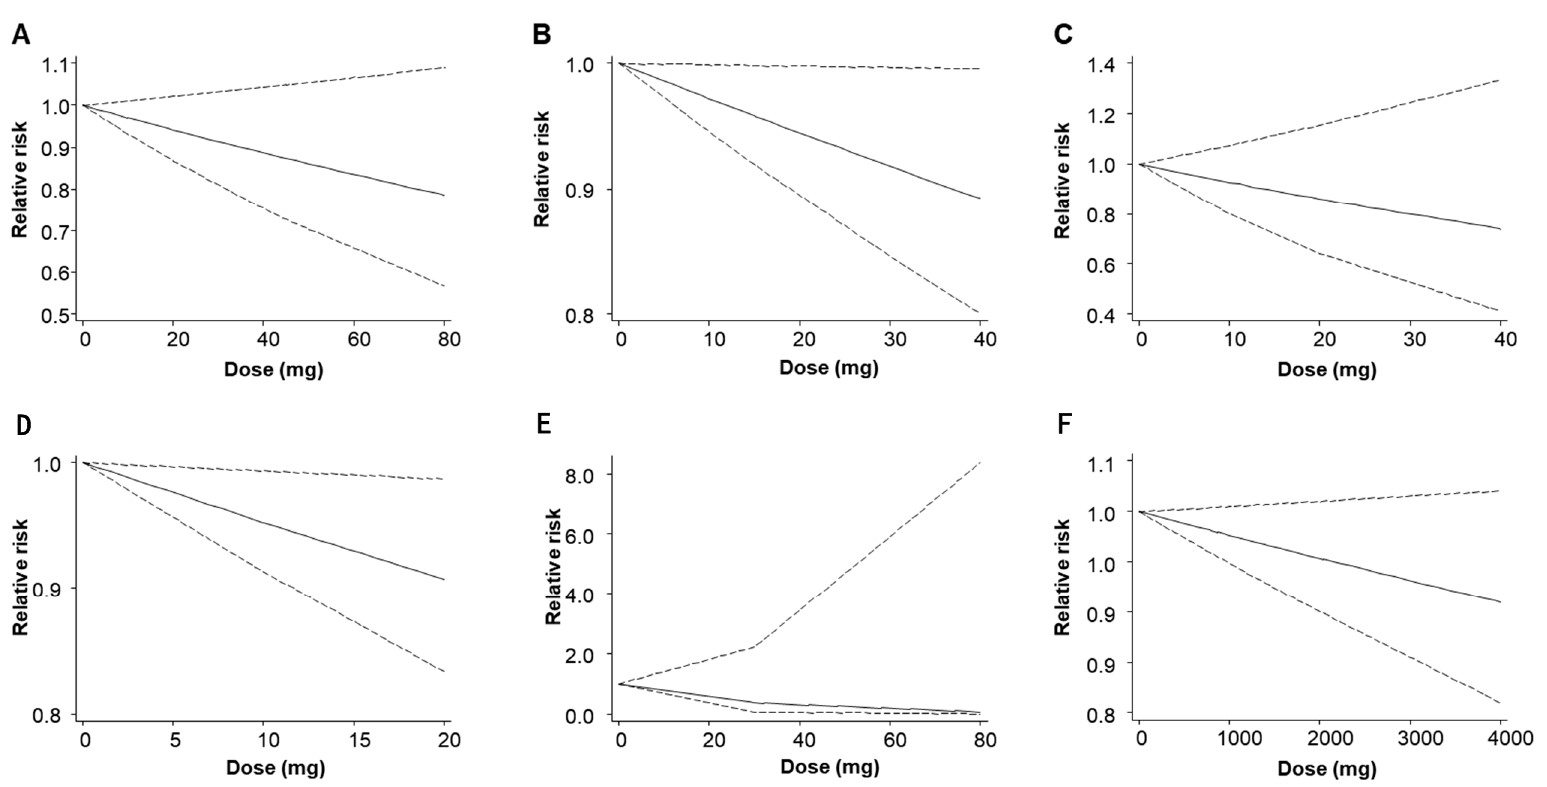
Figure A12. Dose–response meta-analysis of the association between ( A ) atorvastatin, ( B ) pravastatin, ( C ) simvastatin, ( D ) rosuvastain, ( E ) lovastatin, and ( F ) omega-3 supplementation with all-cause mortality.